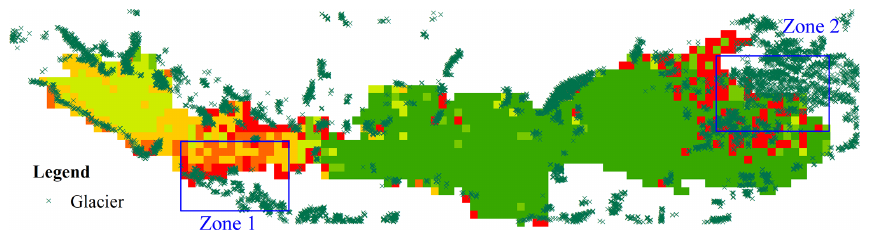
Figure 13. Spatial distribution of VIC snow depth and glacier in YZR